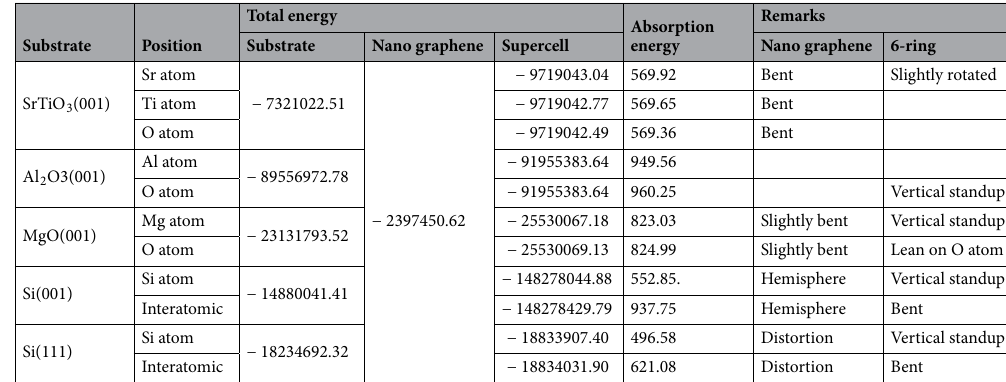
Table S1. A carbon atom (C), six-membered ring (6-ring) and seven six-membered ring (nanographene) were used as typical carbon clusters, as shown in Fig 2. Each cluster was optimized, and total energy (E cluster ) was estimated. The optimized carbon cluster was placed on the surface of strontium titanate (SrTiO 3 ), sapphire (Al 2 O 3 ), magnesium oxide (MgO) and silicon (Si) substrates, and after optimizing supercell structure, total energy of supercell was estimated (E supercell ). Absorption energy, E absorp , was estimated by E = E + E − E absorp sub cluster supercell . The carbon cluster was placed on either Sr, Ti or O atom on SrTiO 3 (001) surface as an initial condition. The evaluated absorption energies are shown in Table 2. Figure 3 shows schematics of optimal supercell of carbon